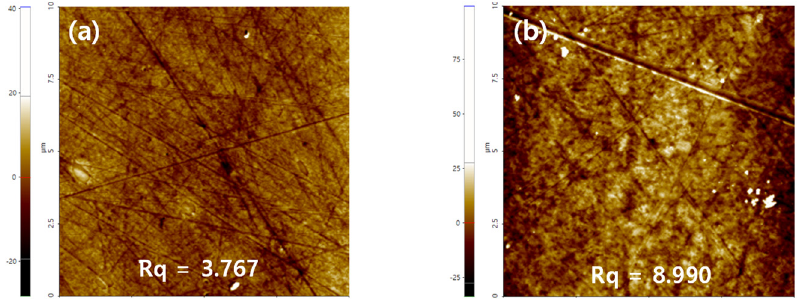
Figure 12. AFM analysis of ( a ) Ref sample and ( b ) M0.1N5S1 sample.